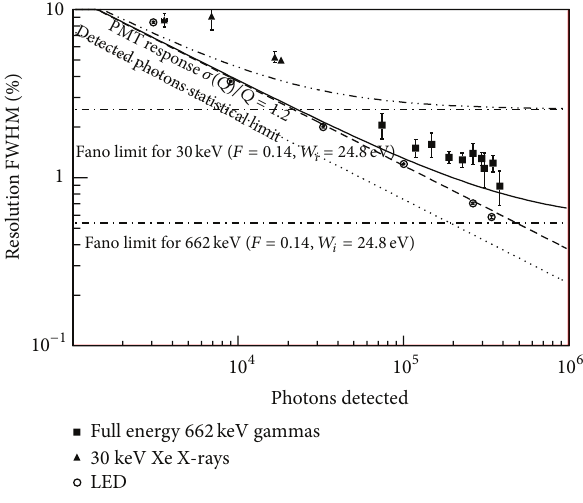
Figure 34: Energy resolution in the high-pressure xenon NEXT-DBDM electroluminescent TPC. Data points show the measured energy resolution for 662keV gammas (squares), ∼ 30 keV xenon X-rays (triangles), and LED light pulses (circles) as a function of the number of photons detected. The expected resolution including the intrinsic Fano factor, the statistical fluctuations in the number of detected photons, and the PMT charge measurement variance is shown for X-rays (dot dot dashed) and for 662 keV gammas (solid line). Resolutions for the 662 keV peak were obtained from 15.1atm data runs while X-ray resolutions were obtained from 10.1atm runs